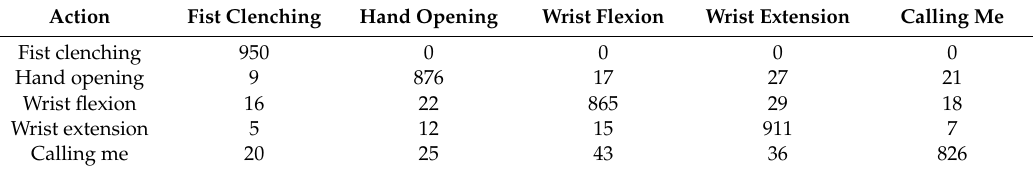
Table 3. Confusion matrix evaluation of the BP neural network. The classification results are further refined in this table. The diagonal elements represent the number of samples classified correctly, which meets the accuracy in Table 2. Other elements mean the number of samples that are misclassified. More importantly, through the confusion matrix, it is clear to see which pattern has been misclassified for a certain sample.